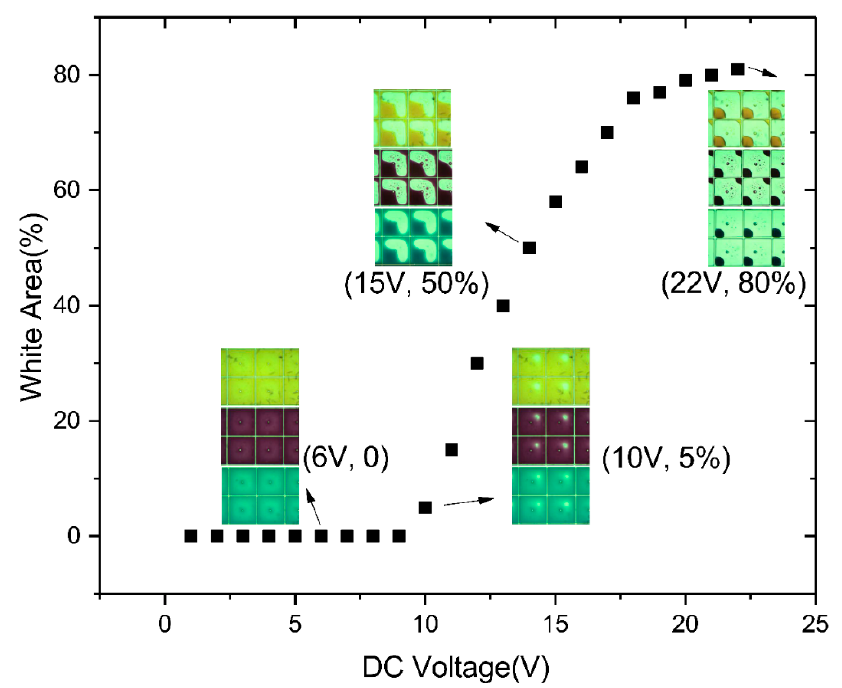
Figure 7. White area versus voltage curve for the fabricated three-layer colorful segmented electrowetting display, showing cyan, magenta, and yellow oil movement in pixels. Pixels are not activated from 0–9 V, threshold voltage for oil rupture is 10 V, ~50% aperture ratio is achieved at 15 V, and 80% aperture ratio at 22 V.